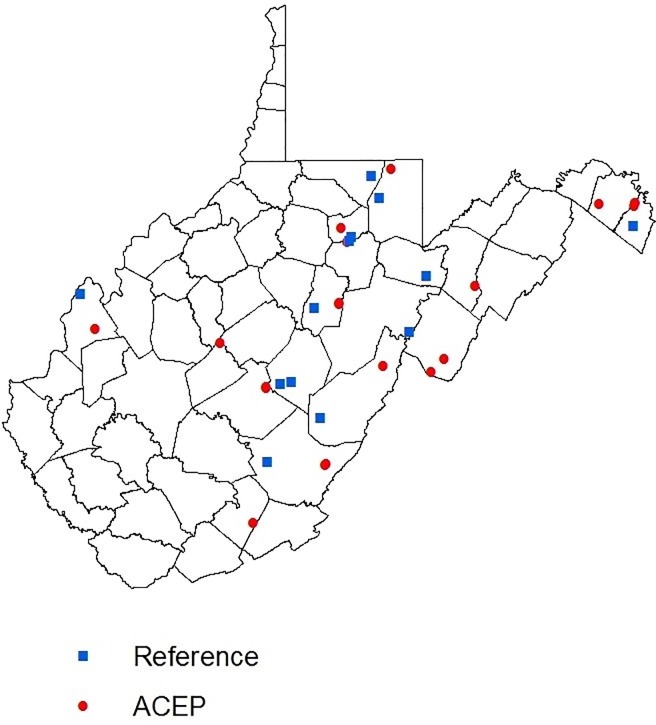
Locations of Agricultural Conservation Easement Program (ACEP) and reference wetlands in West Virginia, USA, in the winters of 2016–2017 and 2017–2018.ACEP properties were administered through the Natural Resources Conservation Service in West Virginia, USA. Reference wetlands were located on public land on West Virginia Division of Natural Resources Wildlife Management Areas and State Parks, and The Nature Conservancy land.